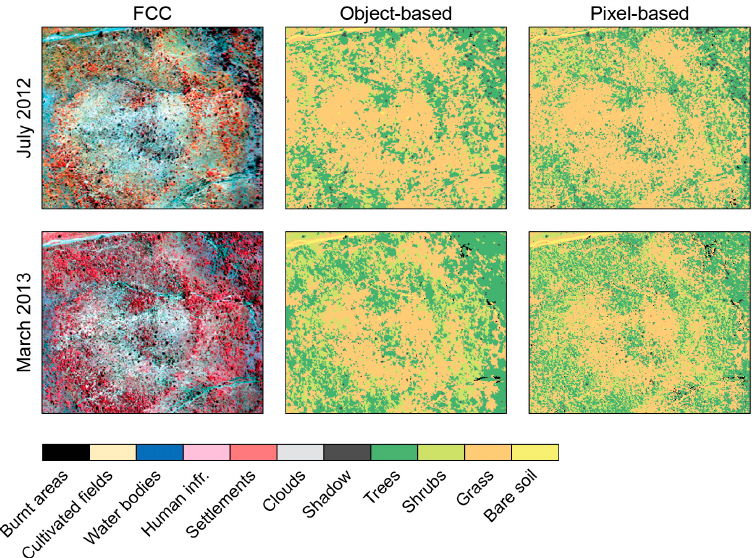
Figure 2. Subset of a WorldView-2 images (false color composite (FCC)) with corresponding Object-Based Image Analysis (OBIA) and pixel-based classifications of wet and dry season using support vector machines (SVM) classifier.